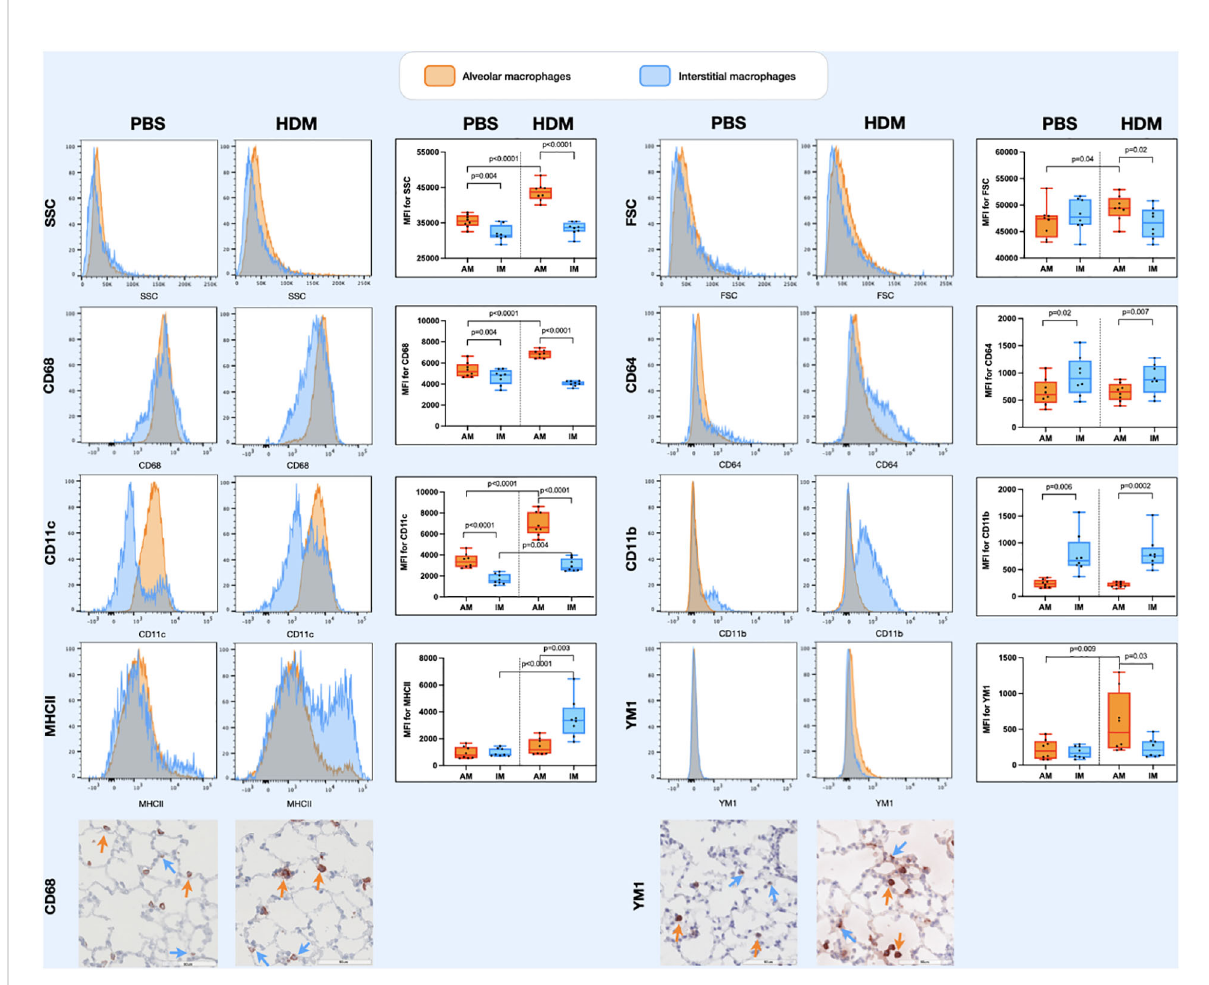
FIGURE 3 Histograms of forward scatter (FSC), side scatter (SSC), and expression of CD64, CD68, CD11c, CD11b, MHCII and YM1 in alveolar macrophages and interstitial macrophages of both a representative PBS and HDM-exposed mouse from day 11.2 of the model. Graphs to the left of the histograms show quanti fi cations of the mean fl uroscence intensity (MFI) of these markers on/in alveolar and interstitial macrophages of all exposed mice. Expression levels on alveolar versus interstitial macrophages were compared using a paired one-way ANOVA with a Sidak ’ s correction for multiple testing because these cells were isolated from the same animals. Expression levels on alveolar or interstitial macrophages in PBS-exposed animals versus HDM-exposed animals were compared using an unpaired one-way ANOVA with a Sidak ’ s correction for multiple testing because these cells were isolated from different animals. P-values <0.05 were considered statistically signi fi cant. Bottom panels are representative immunohistochemical stainings of CD68 (left) and YM1 (right) of lung tissue of a PBS and a HDM-exposed mouse. Positive cells are stained red and a selection of positive alveolar macrophages are indicated with orange arrows and positive interstitial macrophages with blue